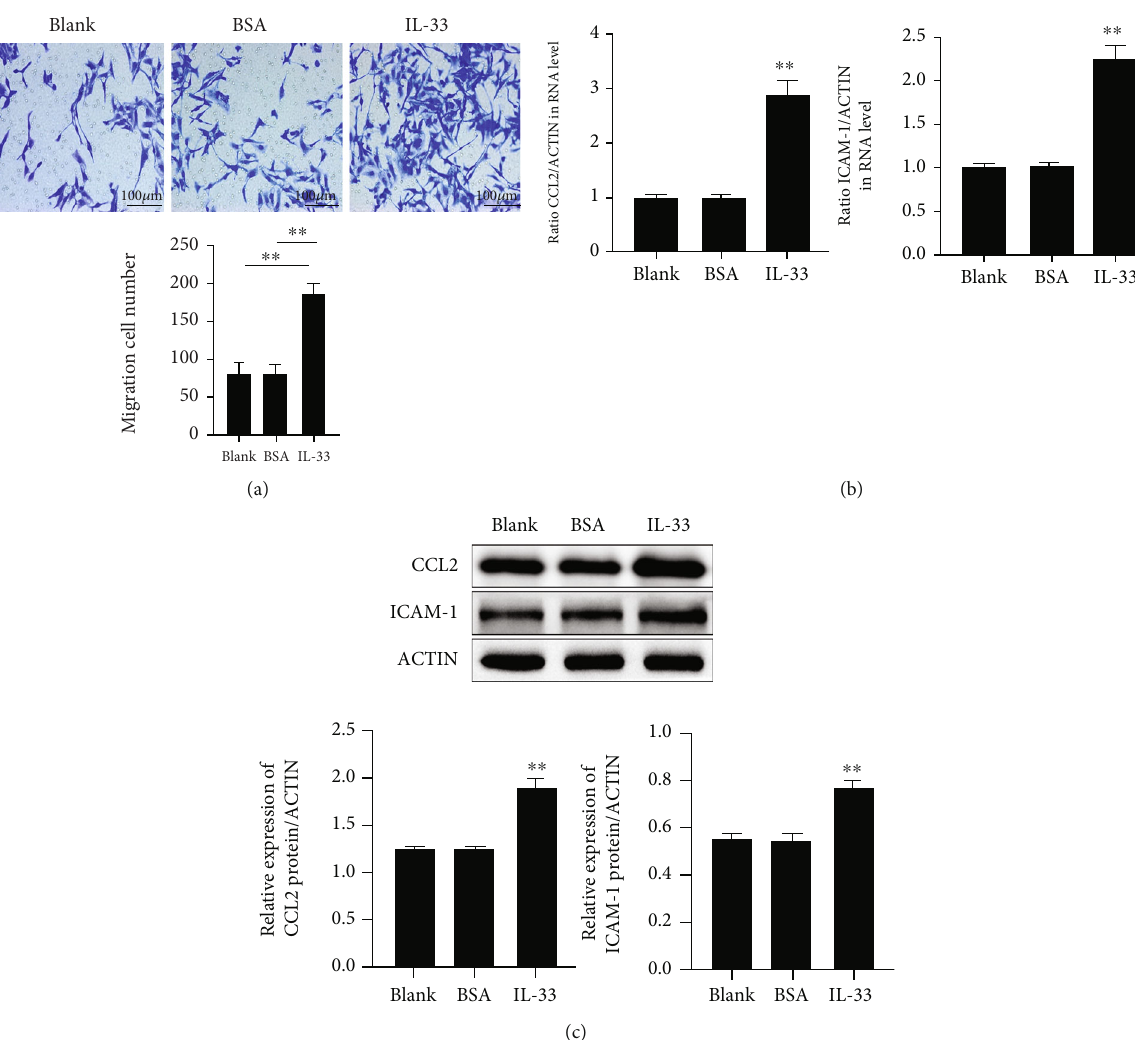
Figure 4: Macrophage chemoattraction is induced by IL-33/ST2 activation in KCs. (a) Transwell detection of the migration of macrophages in di ff erent treatment groups and numerical representation. (b) Detection of ICAM-1 and CCL22 mRNA by qRT-PCR in IL-33-stimulated KCs. (c) Western blot analysis of ICAM-1 and CCL22 expression levels in the supernatants collected from IL-33-stimulated KCs. Data were obtained from three experiments conducted independently. Data points and error bars denote mean ± SEM . ∗ p < 0 : 05 , ∗∗ p < 0 : 01 . KC: